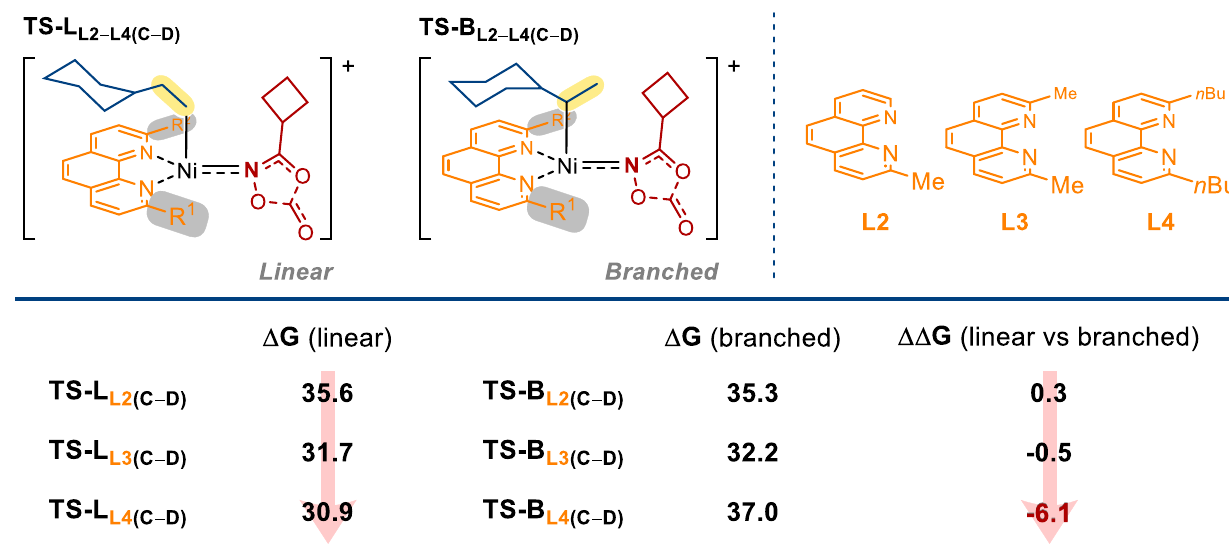
Fig. 9 Relative barriers calculation for the linear (anti-Markovnikov) hydroamidation vs. branched (Markovnikov) hydroamidation. Rate-determining